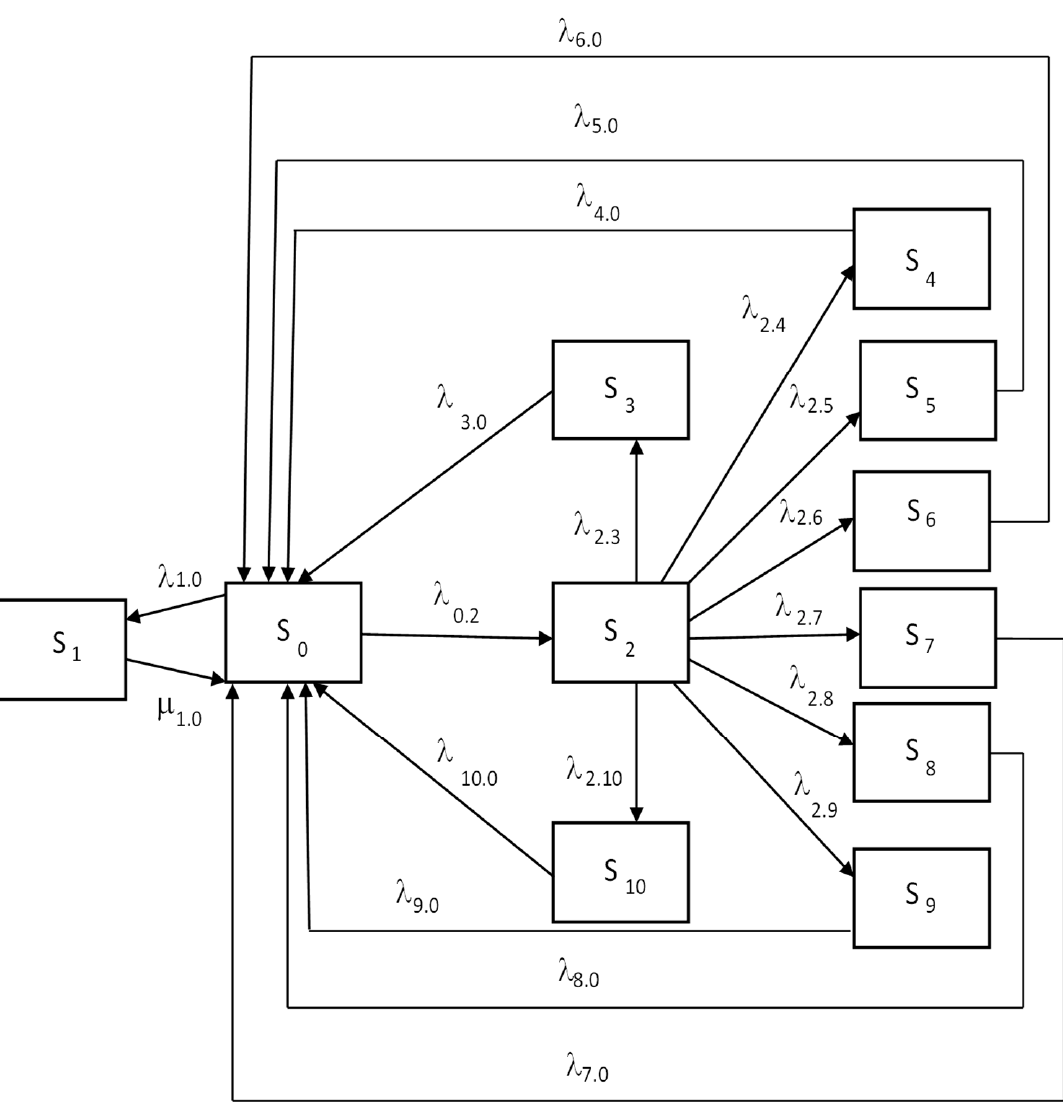
A schematic graph of the state for the fuel system of a diesel engine is shown in Figure 1.